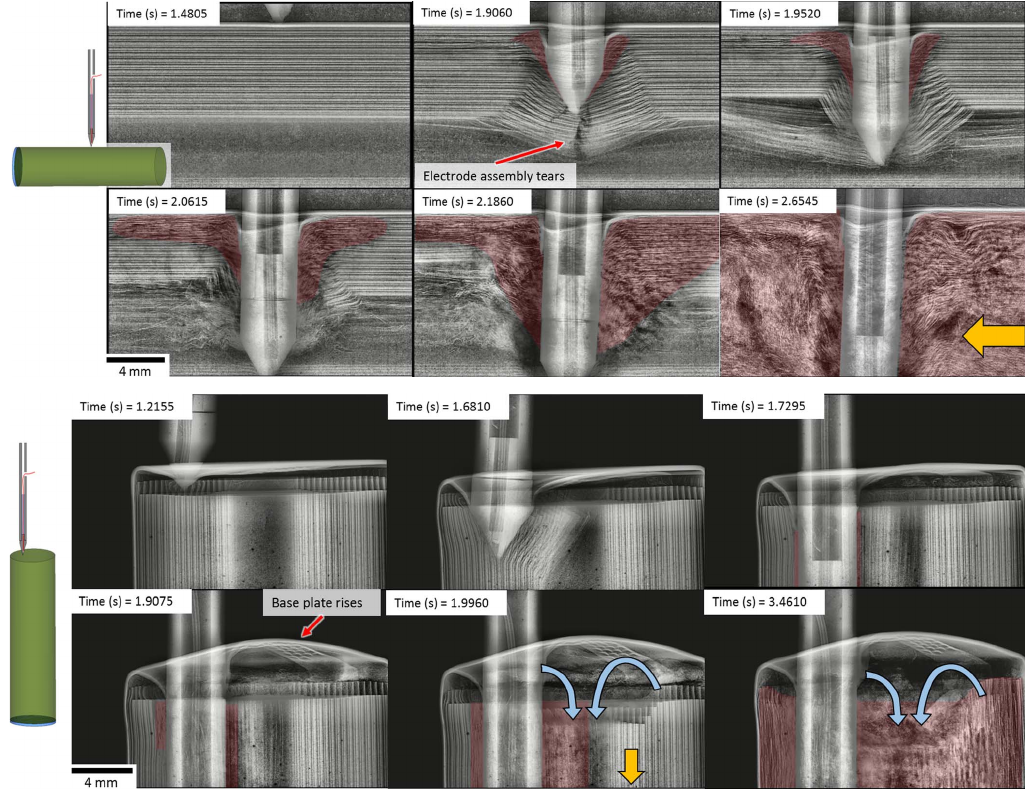
Figure 11. Thermal runaway propagation after nail penetration for battery placed horizontally and vertically [75].